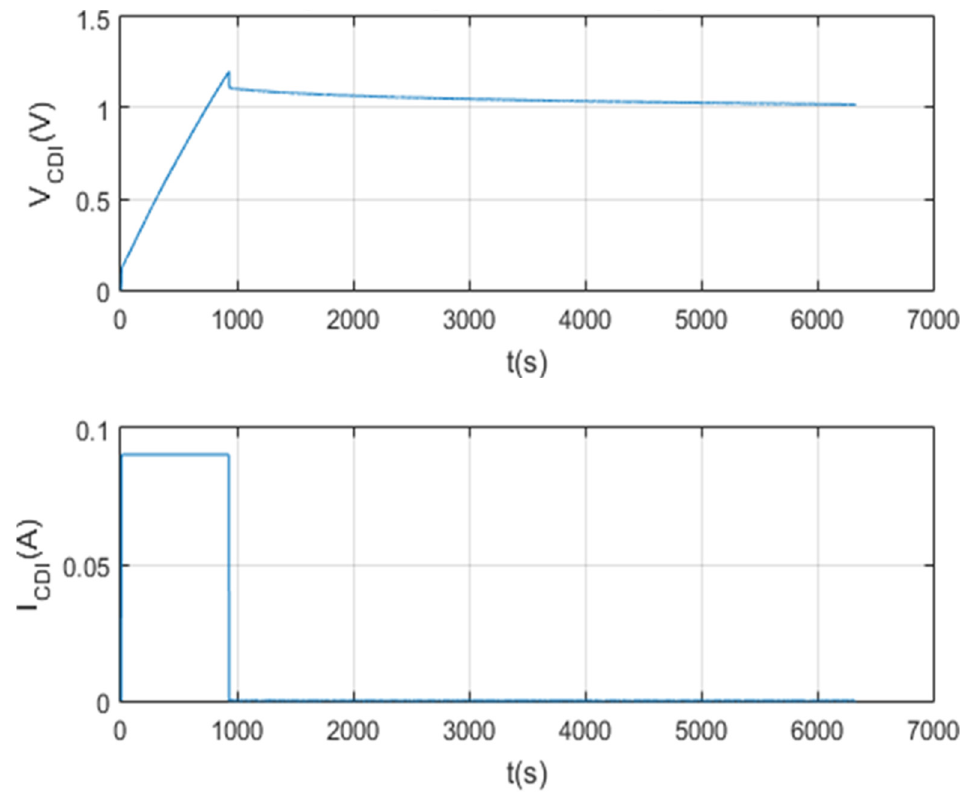
Figure 15. Self-discharge analysis characterizing a 100 F capacitor.